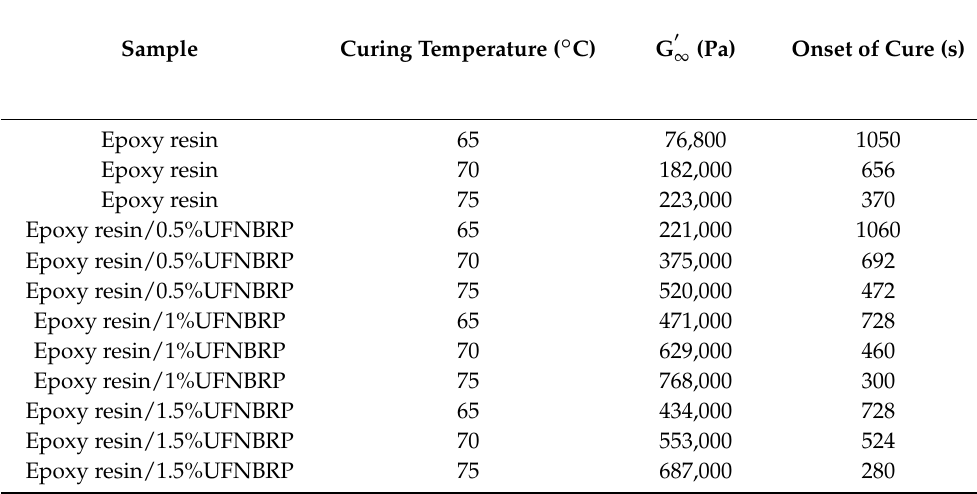
Table 2. Values of G (cid:48) ∞ , onset of cure and cure time for all of the samples at the analyzed temperatures.